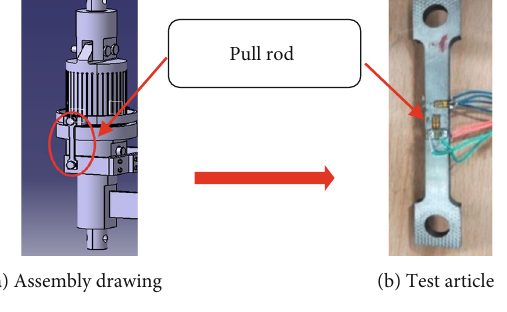
Figure 12: Assembly scheme of the fi nger lock. (a) CAD